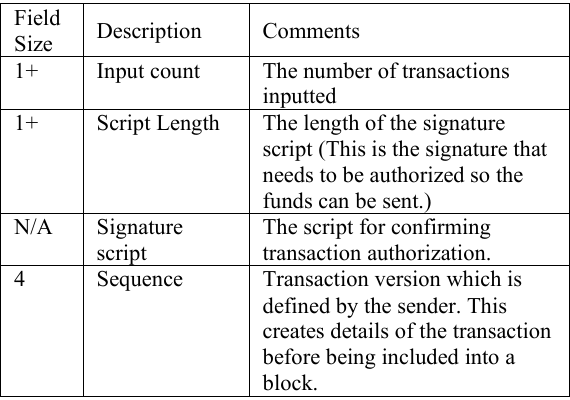
Figure 3. Wireshark analysis on the bitcoin packets. Table 2. Wireshark